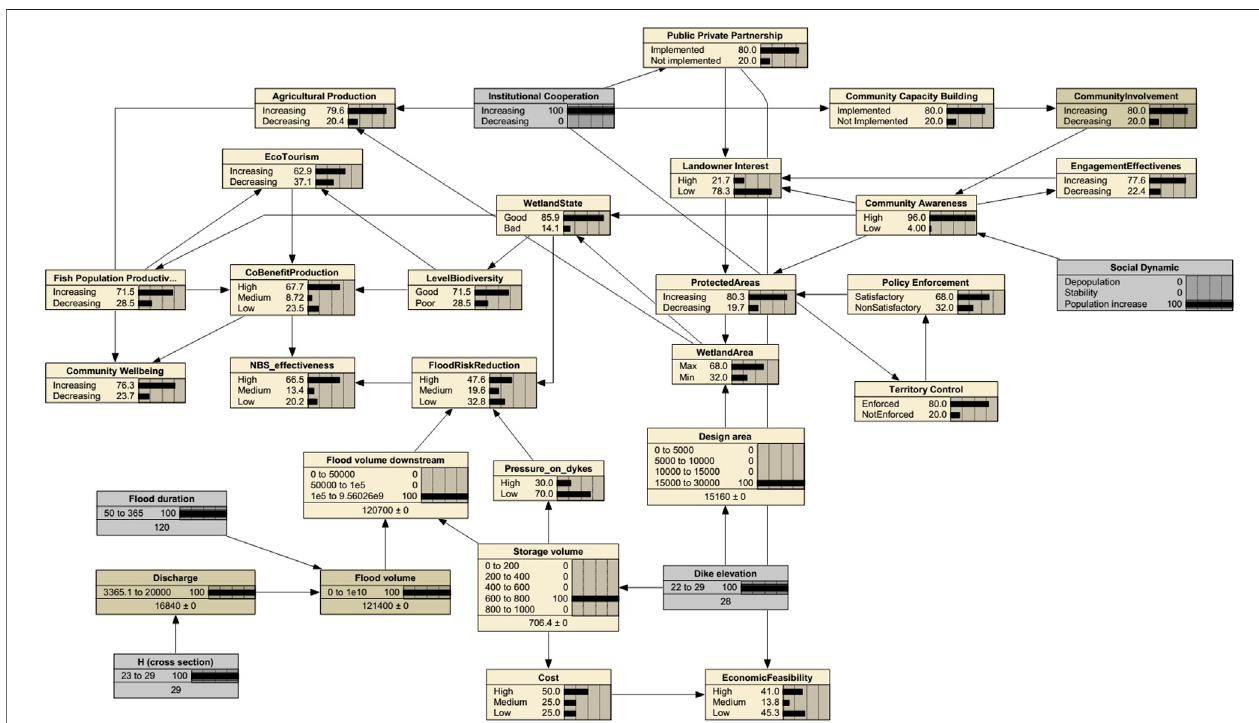
FIGURE 10 | Scenario analysis: 2) “ Improved awareness/cooperation ”